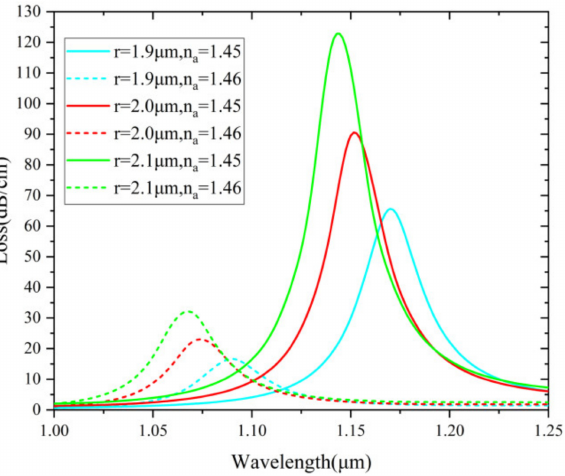
Figure 10. Loss spectra (n a = 1.45 and 1.46) when r is varied from 1.9 to 2.1 µ